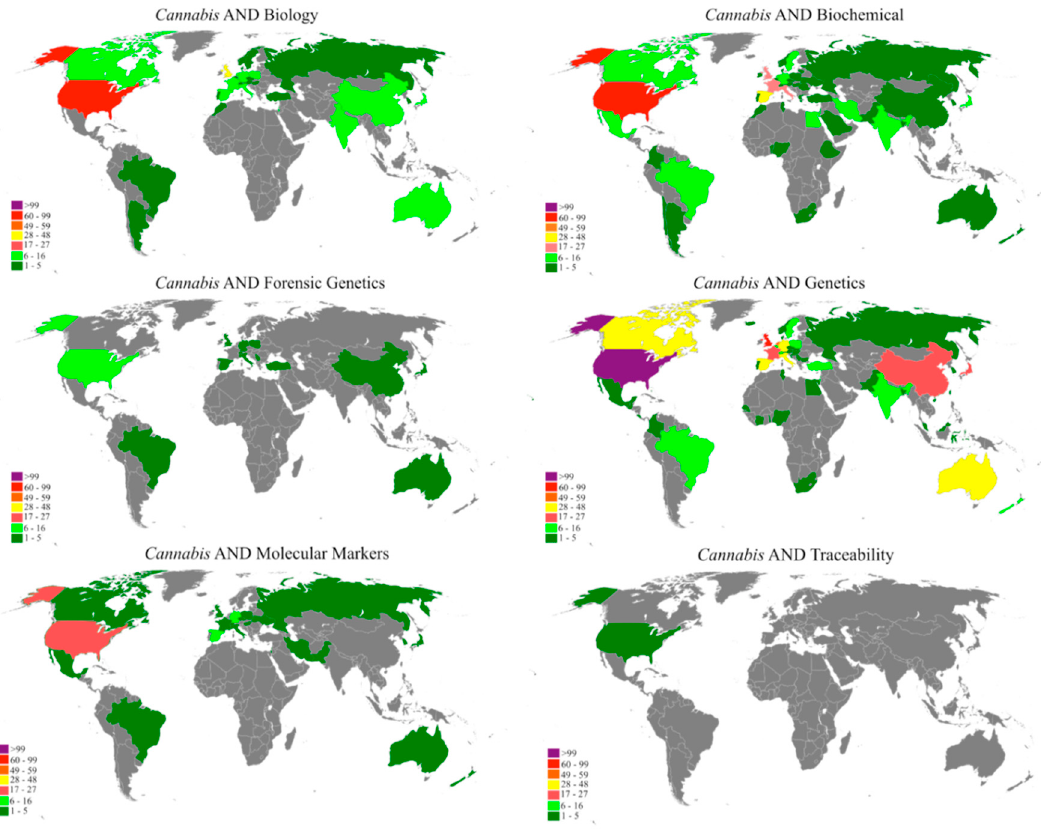
Figure 2. Map of the distribution of the absolute number of publications on Cannabis in each country as recovered from the Scopus platform using six different search arguments.